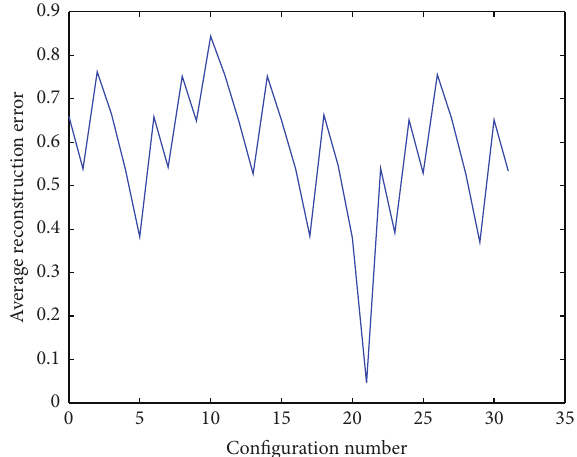
Figure 2: Reconstruction error based on configurations of 𝑥 𝑐 in one trial.